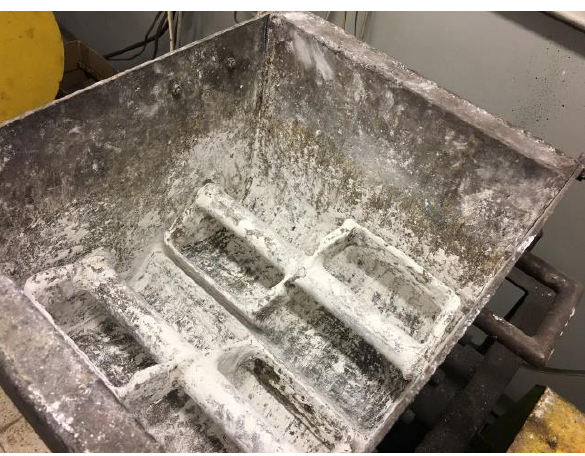
Figure 5. The view of the Z-blade mixer used in the test for material preparation [46].